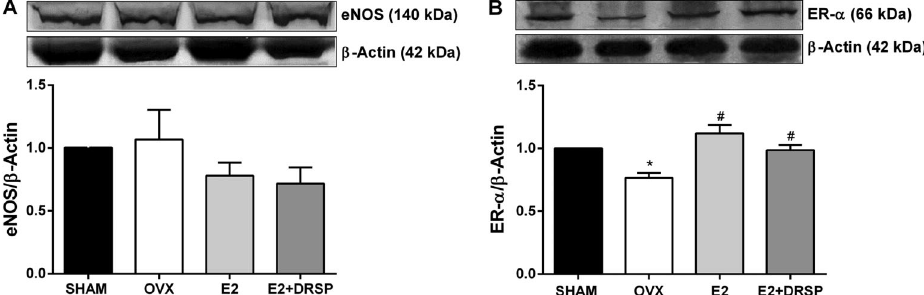
Figure 2. Protein expression of endothelial nitric oxide synthase (eNOS) ( A ) and estrogen receptor alpha (ER- a ) ( B ) in coronary arteries from ovariectomized spontaneously hypertensive rats. Data are reported as means ± SE (n=4 per group). OVX: ovariectomized; E2: estrogen; DRSP: drospirenone. *P o 0.05 compared to Sham, # P o 0.05 compared to OVX (one-way ANOVA followed by Tukey ’ s post hoc